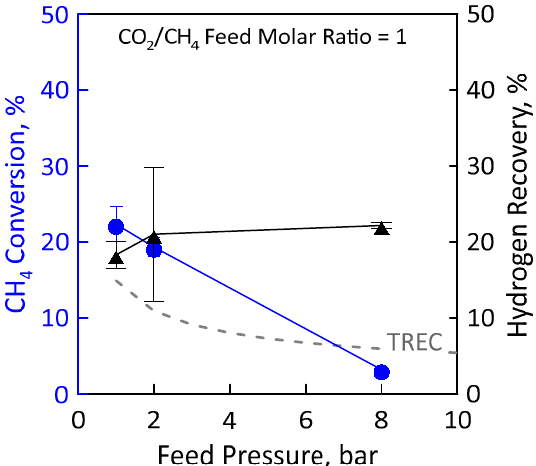
Figure 13. CH 4 conversion ( ● ) and H 2 recovery ( ▲ ) as a function of feed pressures at CO 2 /CH 4 feed molar ratio = 1, permeate pressure = 0.02 bar. Equilibrium conversion values in a traditional reactor (dashed line).